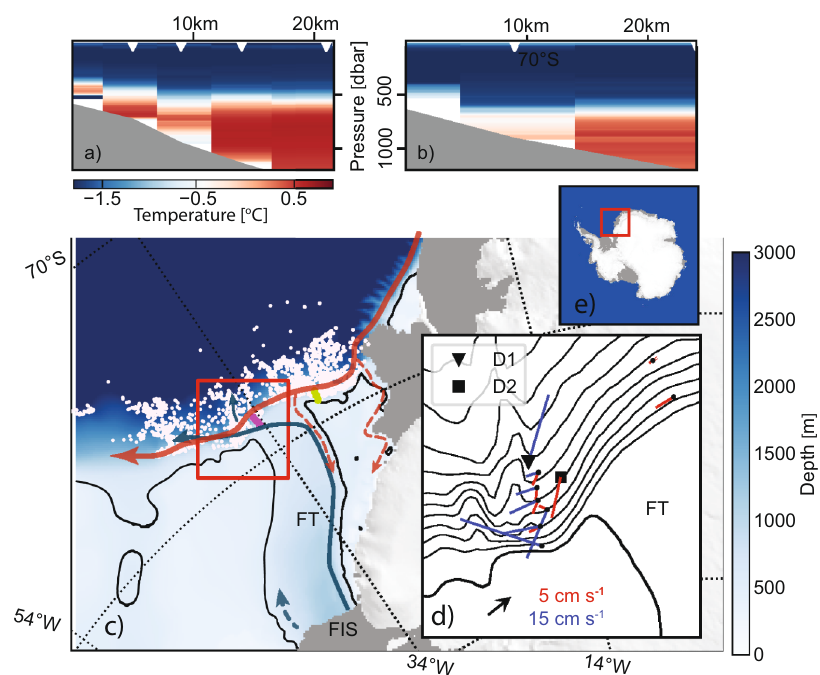
Fig.1|Mapoverthestudyareaandtemperaturesections. Temperaturesections a west and b east of the Filchner Trough (purple/green line in c , respectively). The divergent colormap highlights the depth of the thermocline, with Winter Water above (in blue) and (modi fi ed) Warm Deep Water below (in red). c Map over the study area with bathymetry 27 in blue shading according to the color bar and the 500m isobath highlighted in black. The circulation in the area is shown with blue (out fl ow ofIceShelf Water)and red (the AntarcticSlopeCurrent and the Antarctic Coastal Current) arrows 34,35 . Dashed arrows indicate seasonal fl ow 35,36 . Floating ice shelves are shown in dark gray and land inlight gray.The locationofConductivity-